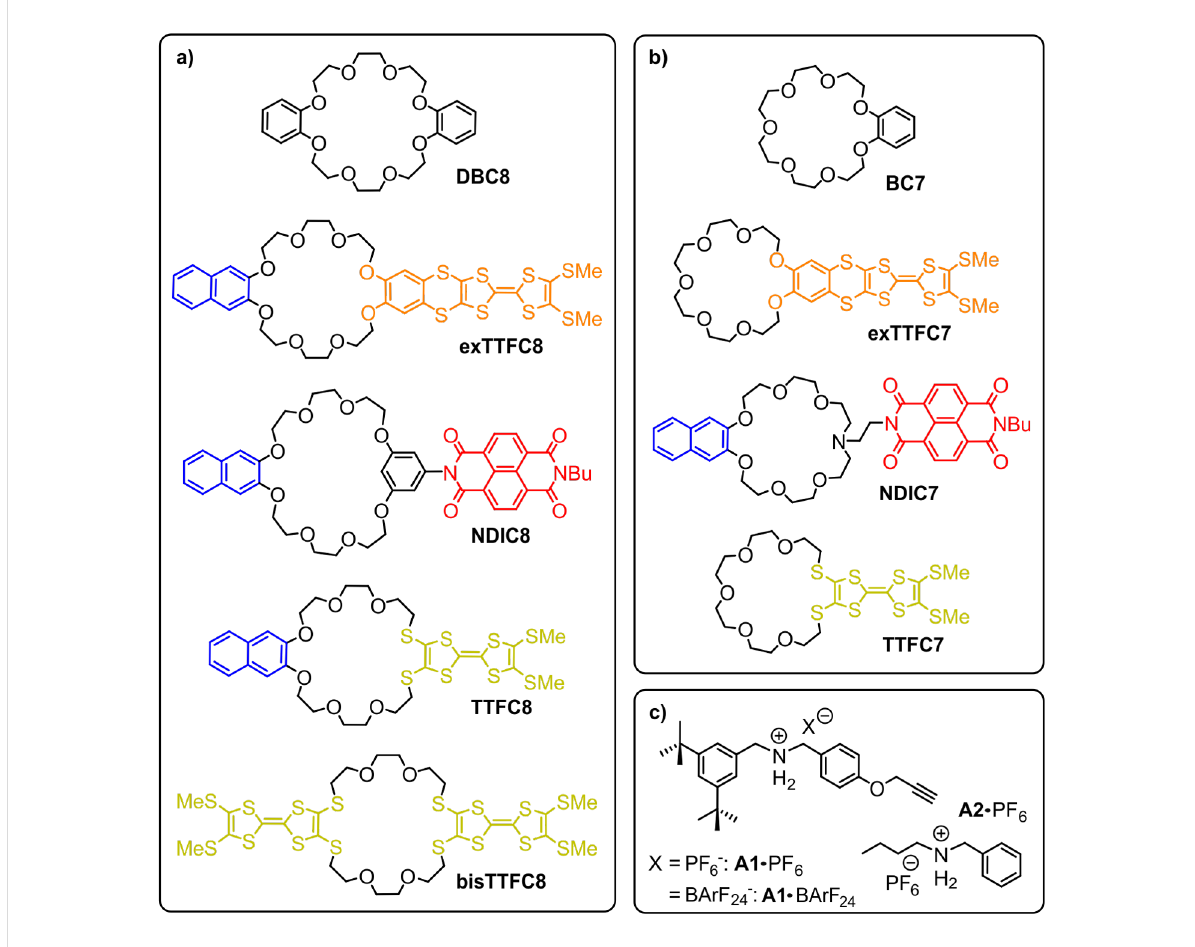
Figure 1: Structures of the compounds used in this study: a) crown-8 analogs; b) crown-7 analogs; c) secondary ammonium axles. BArF 24 − repre- sents tetrakis(3,5-bis(trifluoromethyl)phenyl)borate.